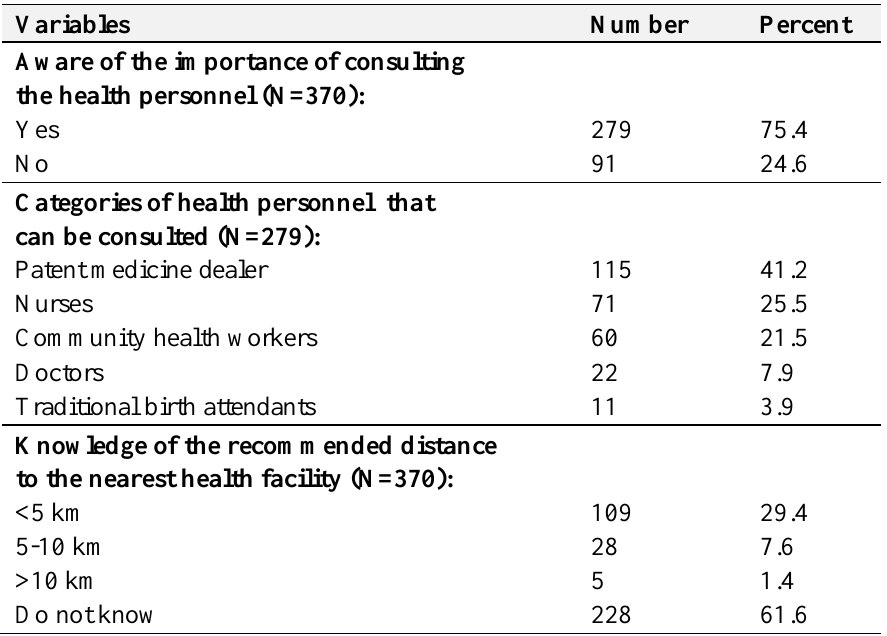
Table 2. Knowledge of primary care services among